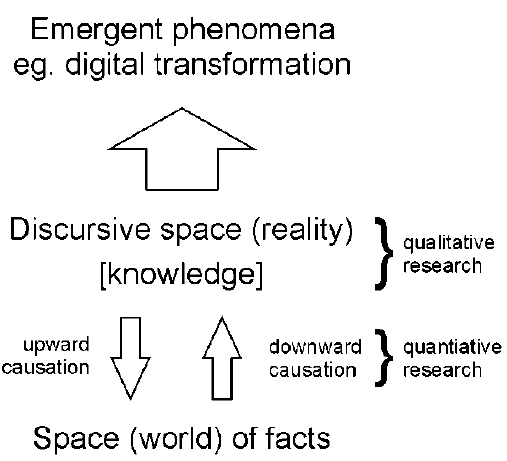
Figure 1. Ontological relations between discursive space, space of facts, and digital transformation.